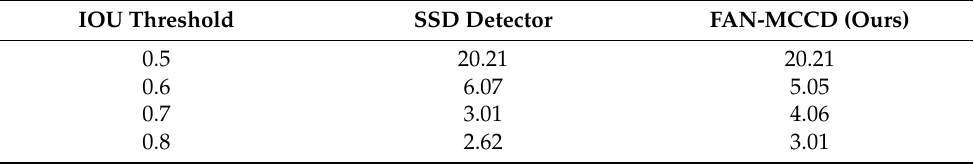
Table 4. Number of anchors matched per character with different IOU